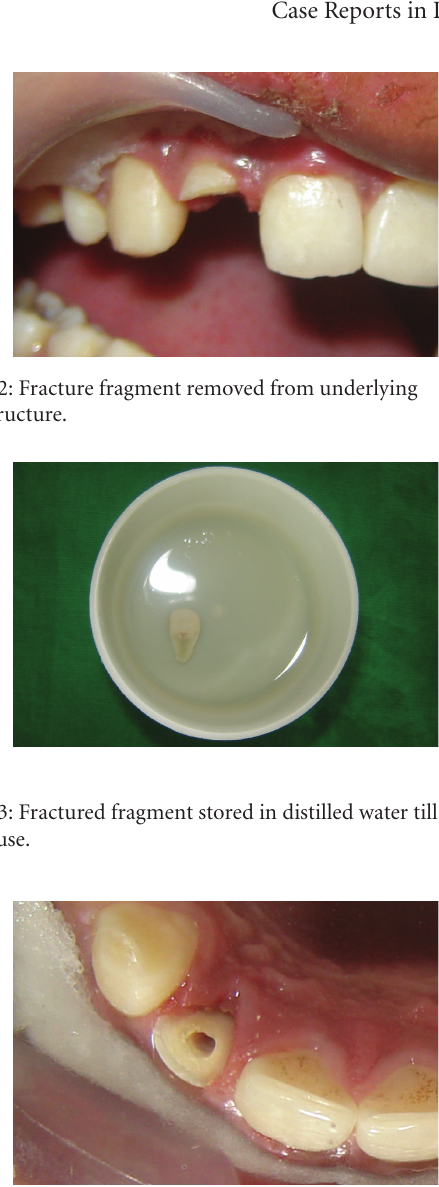
Figure 4: Gelatin sponge was packed on palatal surface in the subgingival area to control any bleeding from that area (mirror